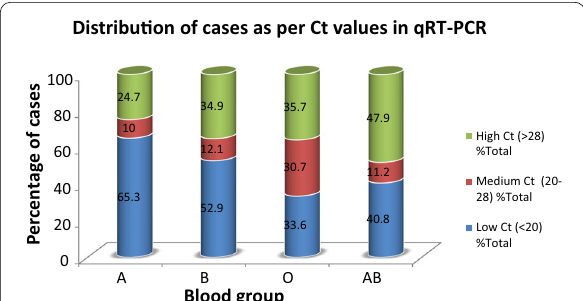
Fig. 2 Distribution of cases as per their Ct values in qRT-PCR